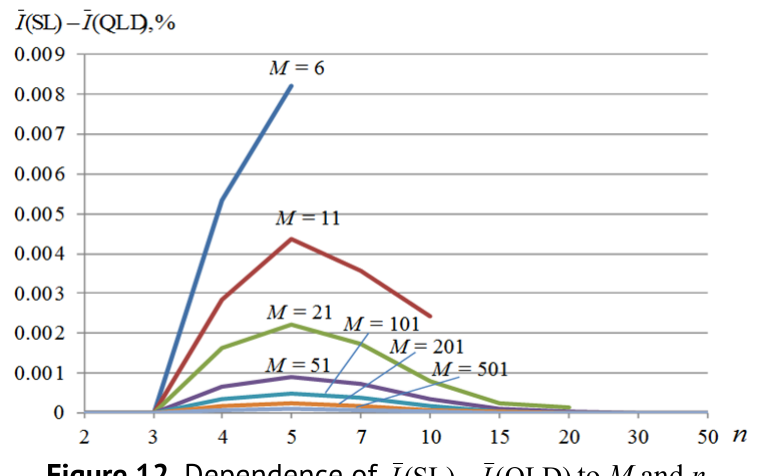
Figure 12. Dependence of to M and n